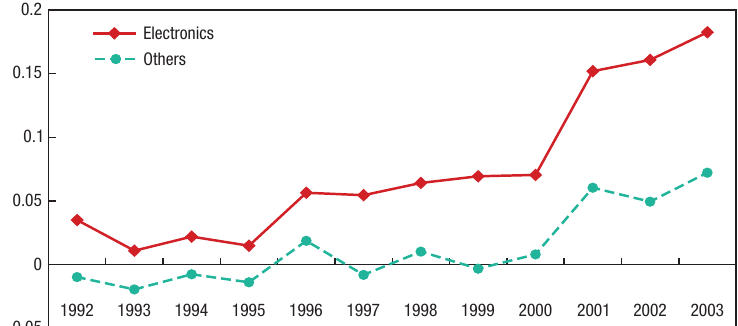
Fig. 3. Dynamics of R&D productivity: electronics vs other manufacturing